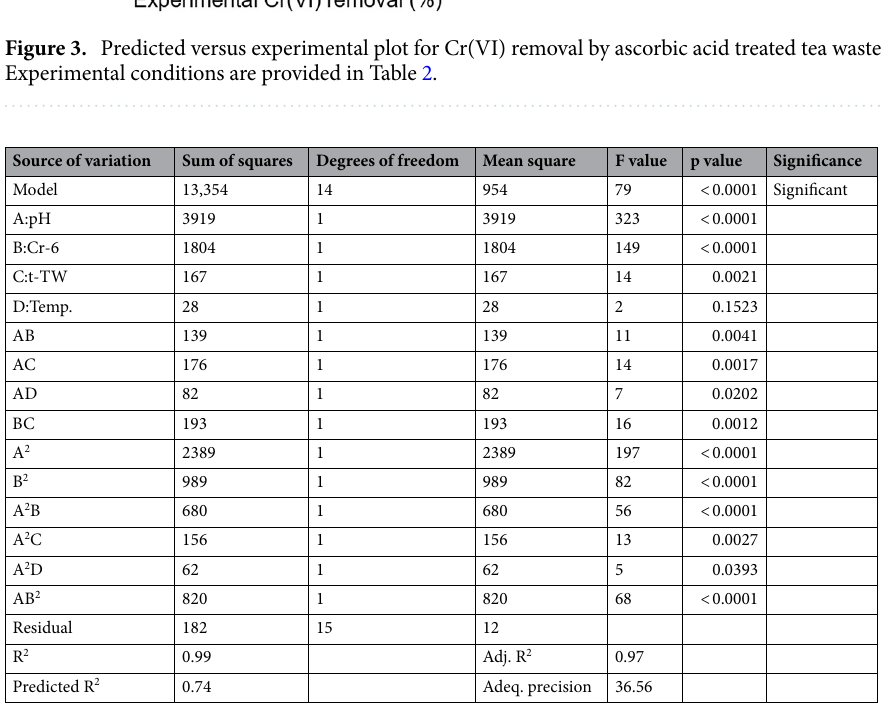
Table 3. Analysis of variance of a reduced cubic model representing adsorptive removal of ascorbic acid treated tea waste.